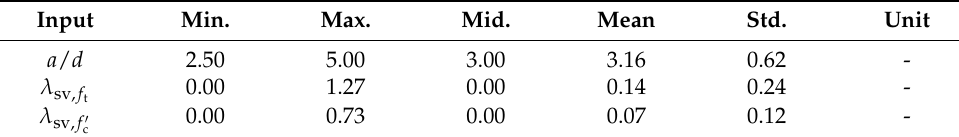
Table 1. Statistical description of the input features in this dataset.